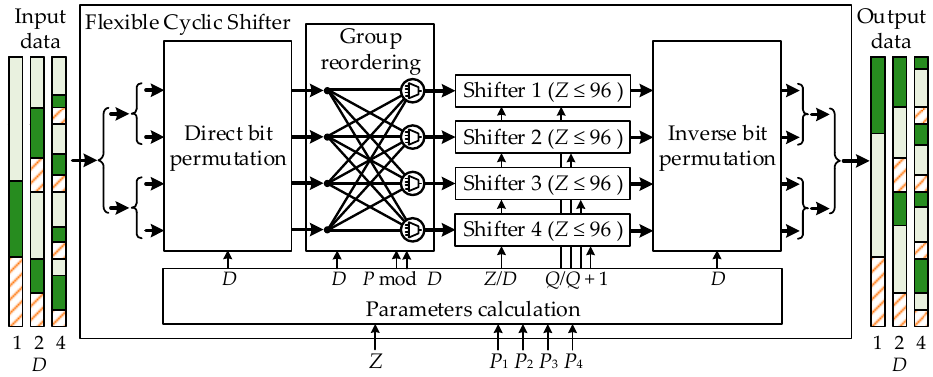
Figure 10. Shifting network architecture for the proposed 5G NR encoder. The network is capable of circular shifting four independent groups of data if Z ≤ 96, two independent groups of data if 96 < Z ≤ 192, and one group of data if 192 < Z ≤ 384.